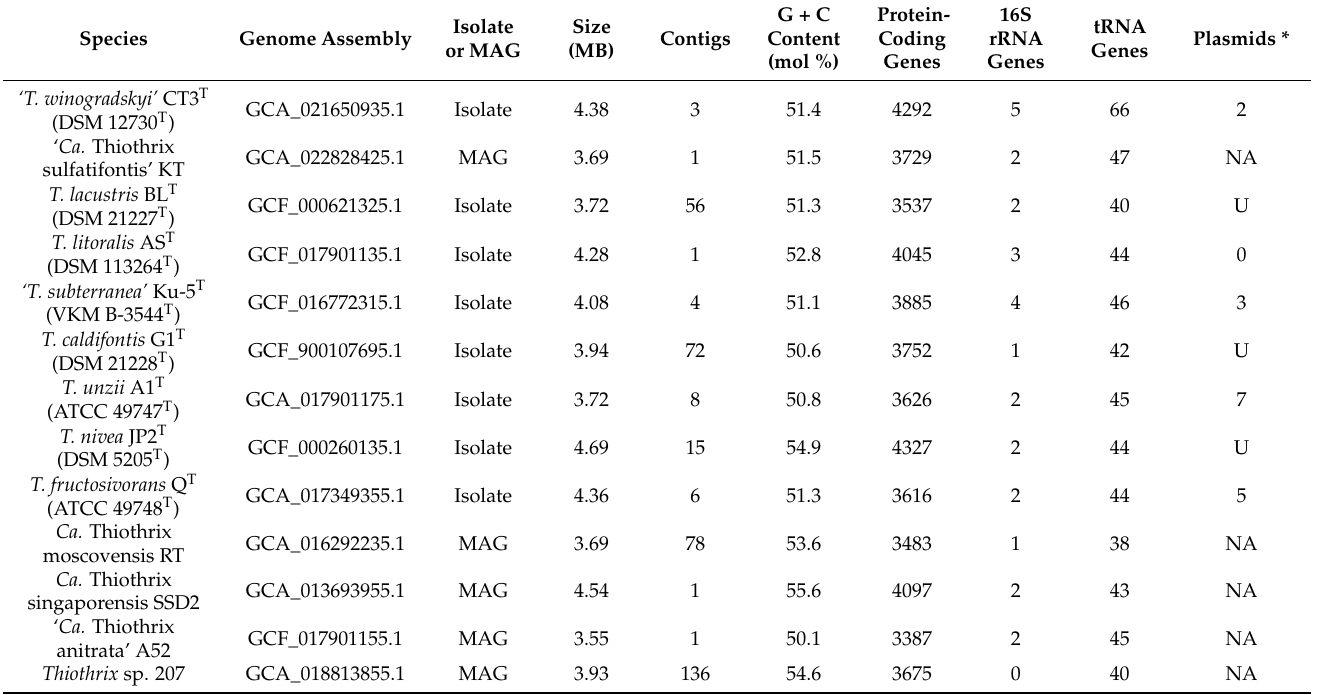
Table 1. The general properties of Thiothrix